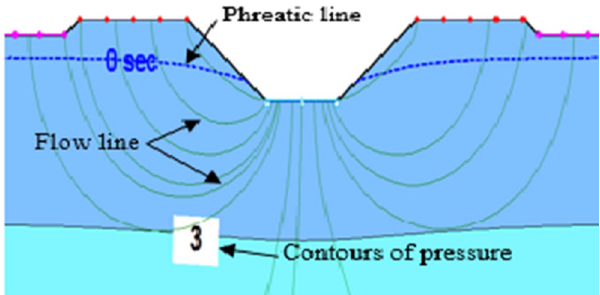
Fig. 6 a Phreatic lines and flow lines for H = 20.8 m without drain pipe, b flow lines with a drain for H = 20.8 m, Y = 19 m, D = 0.2 m, c phreatic lines for different drain diam- eters ( D = 0.1, 0.2 m) with H = 20.8 m, Y = 19 m